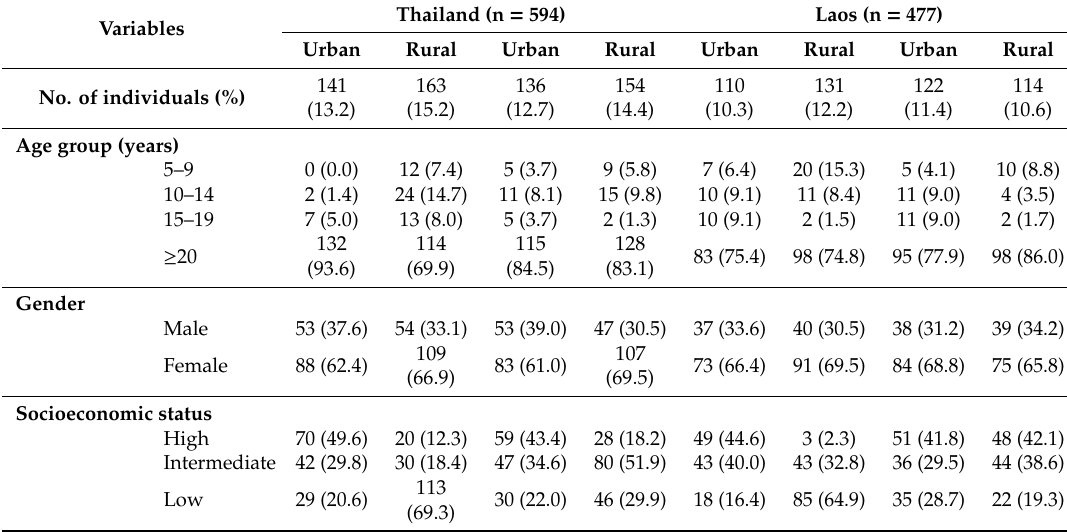
Table 1. General information of participants and households in Laos and Thailand in May 2019.